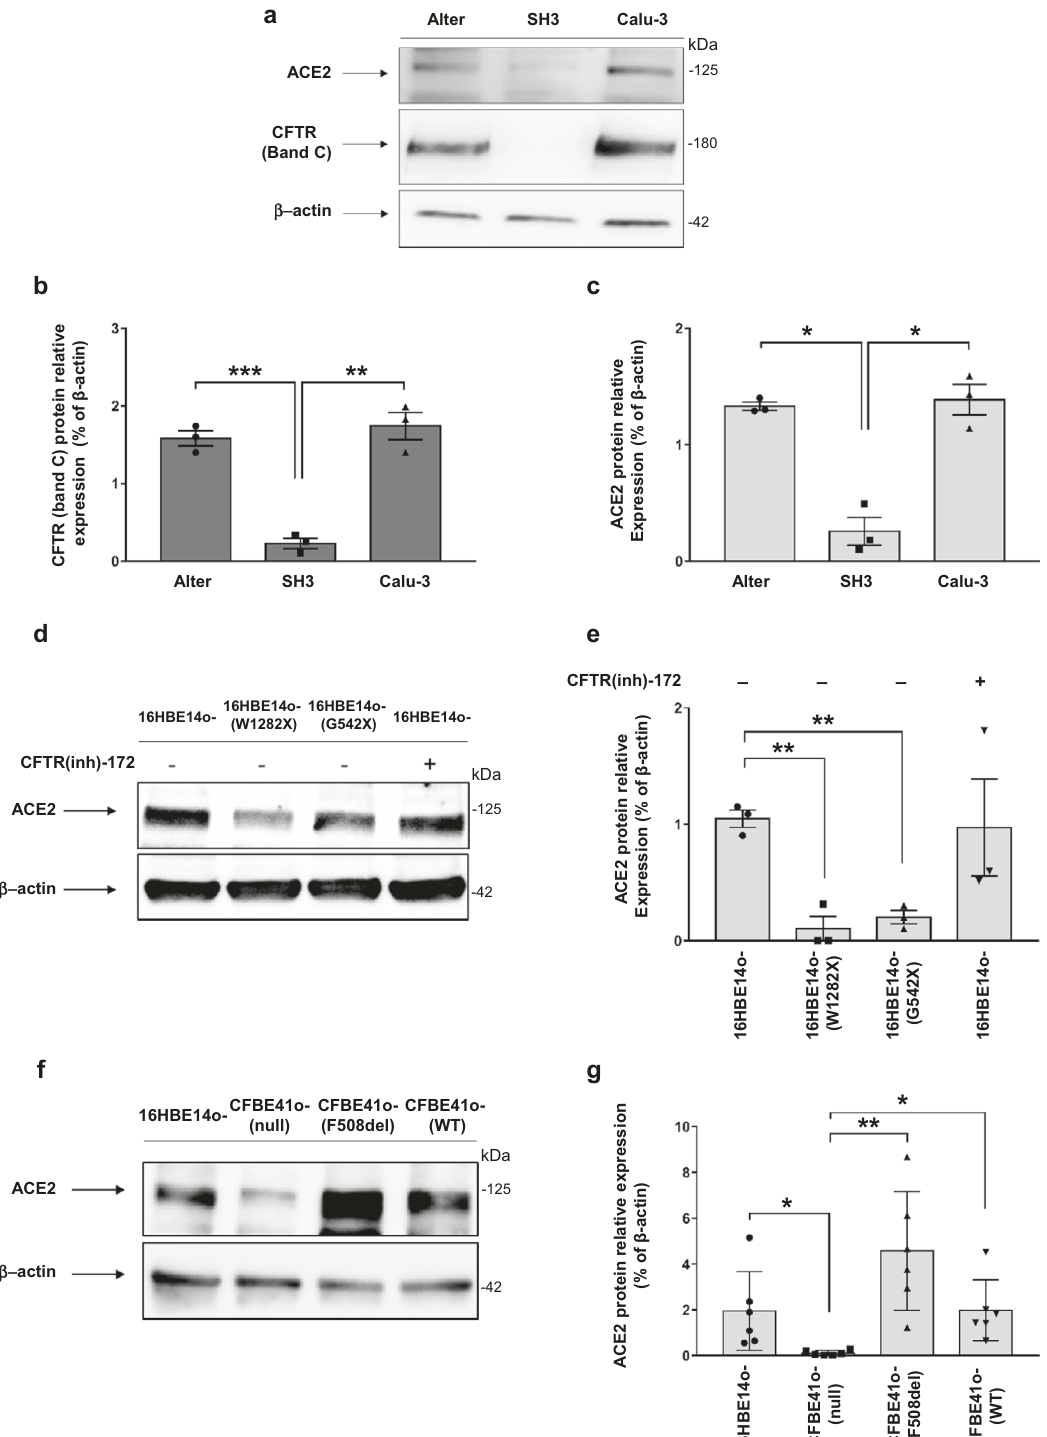
Fig. 2 | CFTR expression positively correlates with ACE2 protein expression in bronchial epithelial cells. a Representative western blot analysis of ACE2 and CFTR in Calu-3, SH3 and Alter cells. b , c Densitometry analysis of CFTR and ACE2 bands depicted in panel ( a ). Data are shown as the mean±SEM of three indepen- dent experiments ( n =3). d Normal 16HBE14o- cells and gene-edited 16HBE14o- cells carrying biallelic W1282X-CFTR or G542X-CFTR mutations, grown under polarizedconditions,wereadditionallyincubatedinthepresence(+)orabsence( − ) of5 μ MCFTRinhibitorCFTR(inh)-172for24h.Proteinswereextractedandwestern blot analysis was performed (representative image). e Densitometry analysis